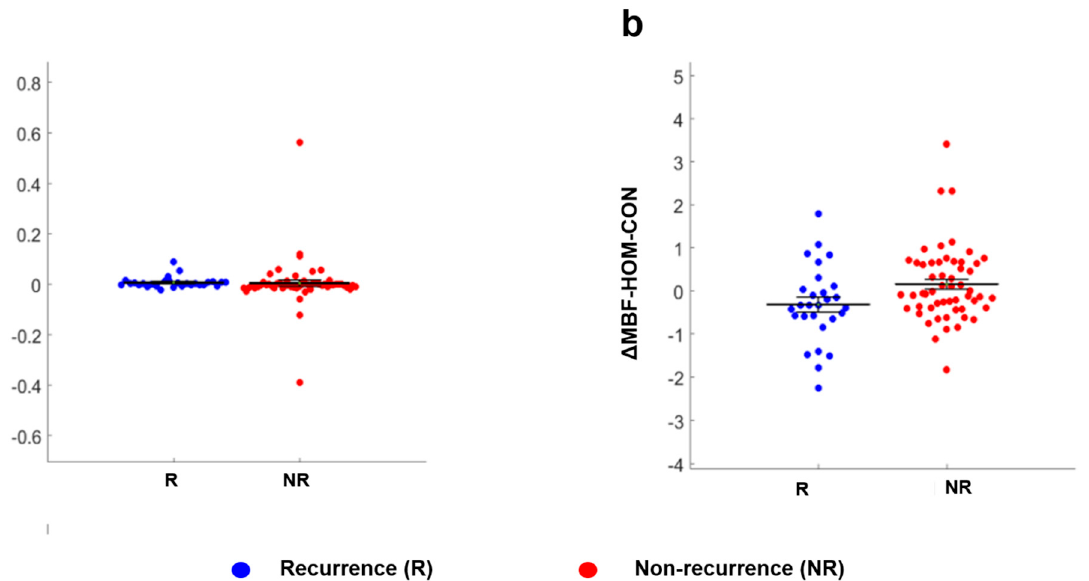
sub-regions of interest within the tumor. The color scale on the right side represents the range for individual features, ASD parameter of 40 to 200 µm, ASD-CON texture feature of 0 to 20, ASD- ∆ Indicates the difference of values of week 4 from week 0 for each feature included in the analysis. Abbreviations: SEM: standard error of the mean; R: Recurrence; NR: No Recurrence; ASD: Average Scatterer Diameter; MBF: Mid- band fit; AAC: Average Acoustic Concentration; ENE: Energy; HOM: Homogeneity; CON: Contrast.